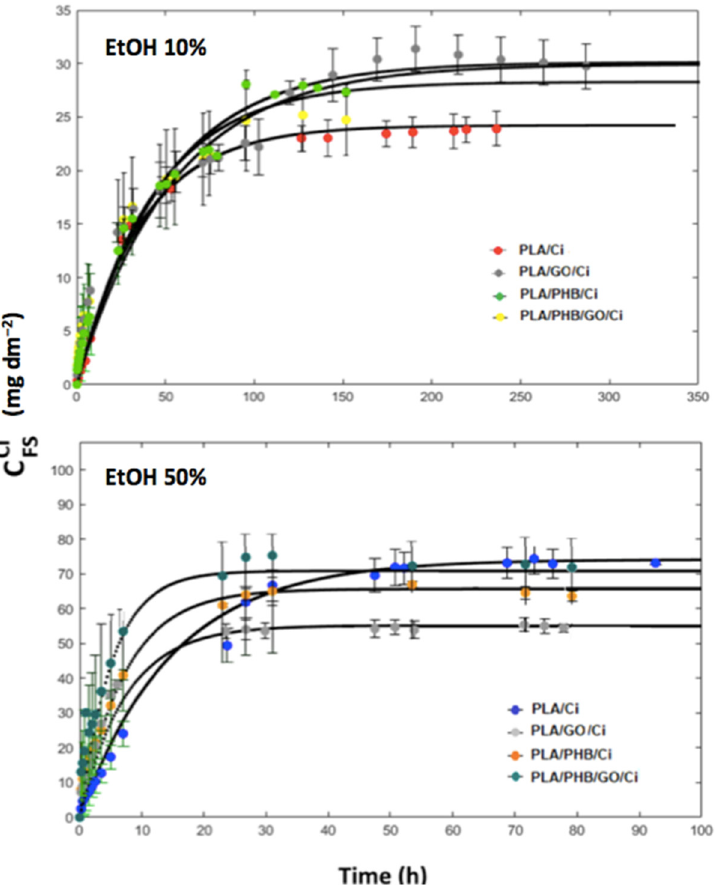
Figure 6. Release kinetics of cinnamaldehyde from the different polymeric systems into different Figure 6. solutions.